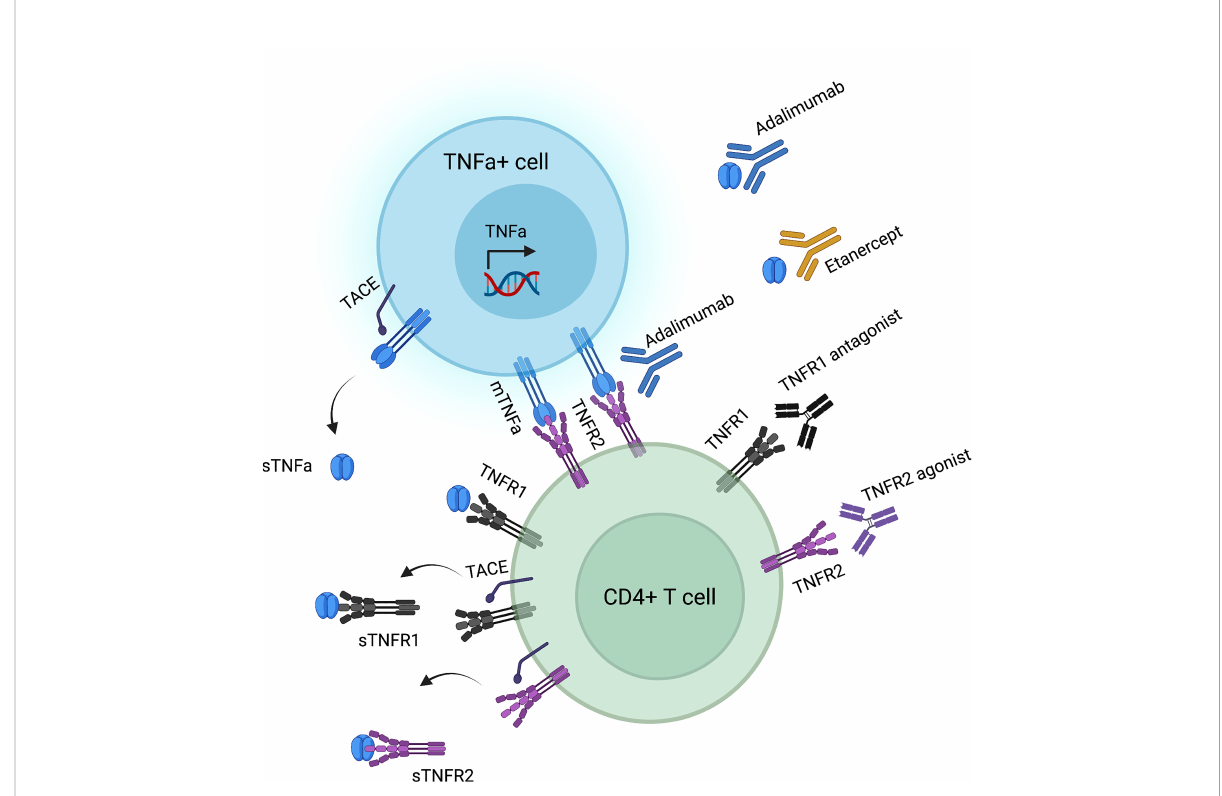
FIGURE 1 TNFa-TNFR interactions and corresponding biologic agents ’ targets. Created by using